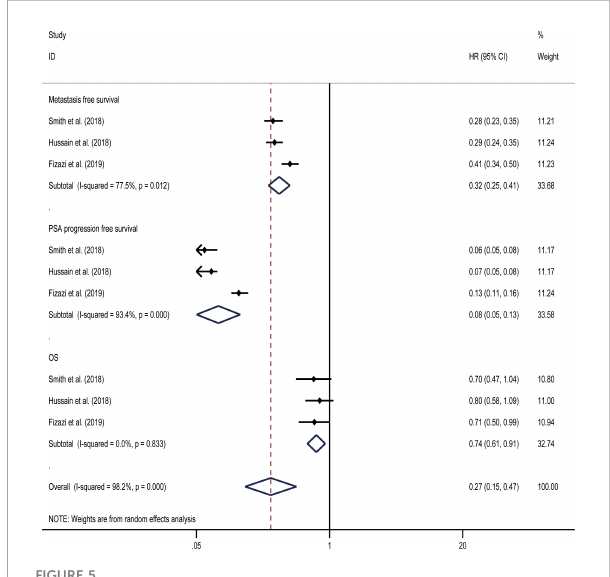
FIGURE 5 Results of a direct meta-analysis on the nmCRPC